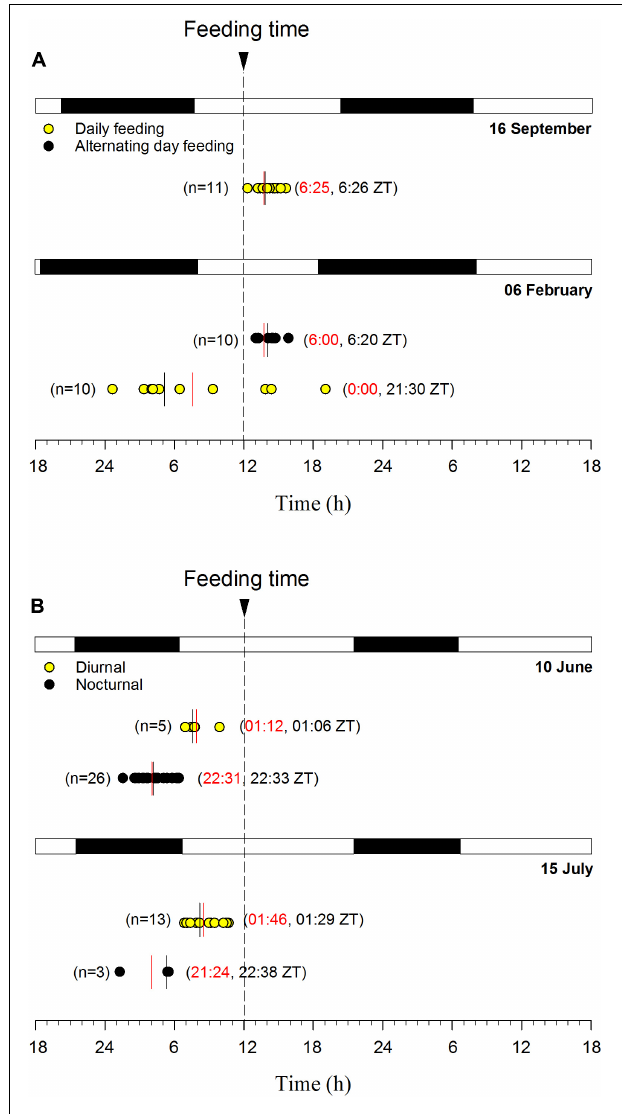
FIGURE 5 | Seasonal activity synchronization by feeding in gilthead sea bream (A) and European sea bass (B) . Circles represent the activity acrophase of the best-fit curve derived from cosinor analysis of physical activity AEFishBIT data (measures taken every 15 min along 2 days) of each individual. At each month, light and dark phases (natural photoperiod) are represented, as well as the feeding time. For gilthead sea bream, fish fed daily (mean body weight 225 g in September, 390 g in February) are represented by red circles, and fish fed during alternate days (mean body weight 385 g) are represented by black circles. For European sea bass fed daily, individuals with diurnal (yellow circles, mean body weight 295 g in June and 345 g in July) and nocturnal (black circles, mean body weight 250 g in June and 255 g in July) behavior are represented. For each group, green bar marks the mean acrophase, and black bar the median. The number of individuals is stated for each